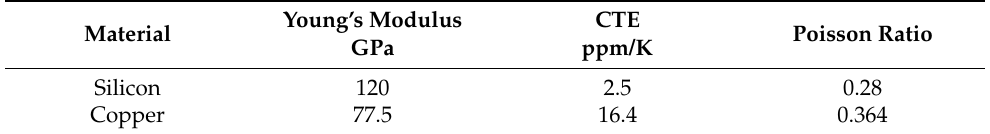
Table 1. Considered material data for